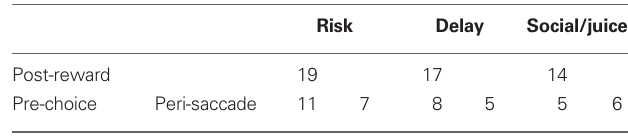
Table 1 | Neurons modulated by choice of the outlier option over the standard option within each task